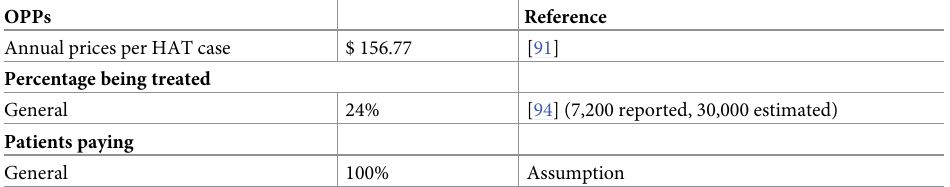
Table 4. Values used to calculate out-of-pocket payments (OPPs) for human African trypanosomiasis (I$—Inter- national